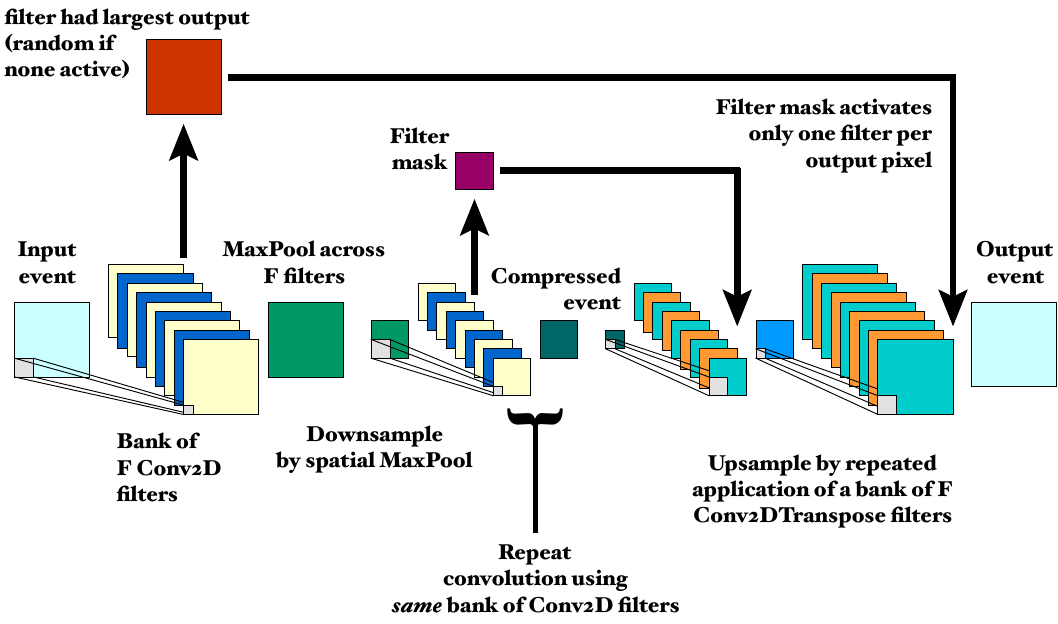
Figure 2 . Overview of the autoencoding CNN. An input event image enters the network on the left and is repeatedly processed by a bank of F Conv2D (cid:12)lters. Having been completely